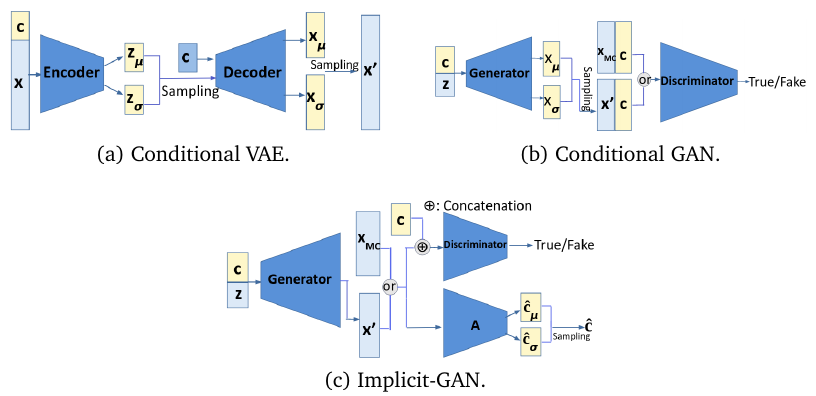
Figure 1: Block-diagram representation of (a) C-VAE, (b) C-GAN, and (c), our pro- posed method, an Implicit-GAN. We refer to the respective parts of the main text, Sec. 2.1, Sec. 2.2, and Sec. 3.2, for a detailed